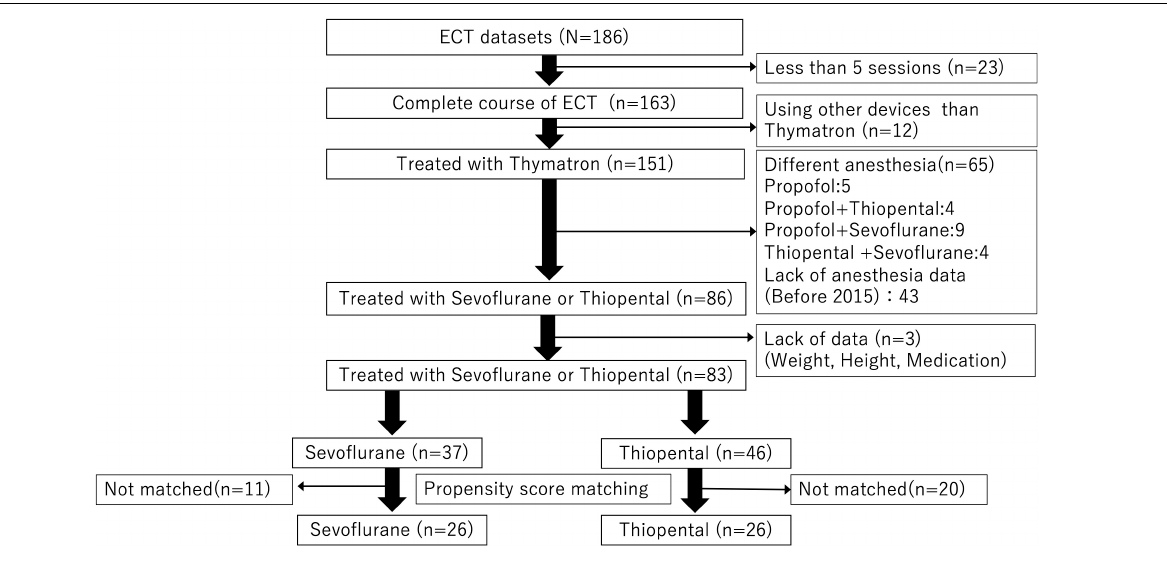
Frontiers in Human Neuroscience |